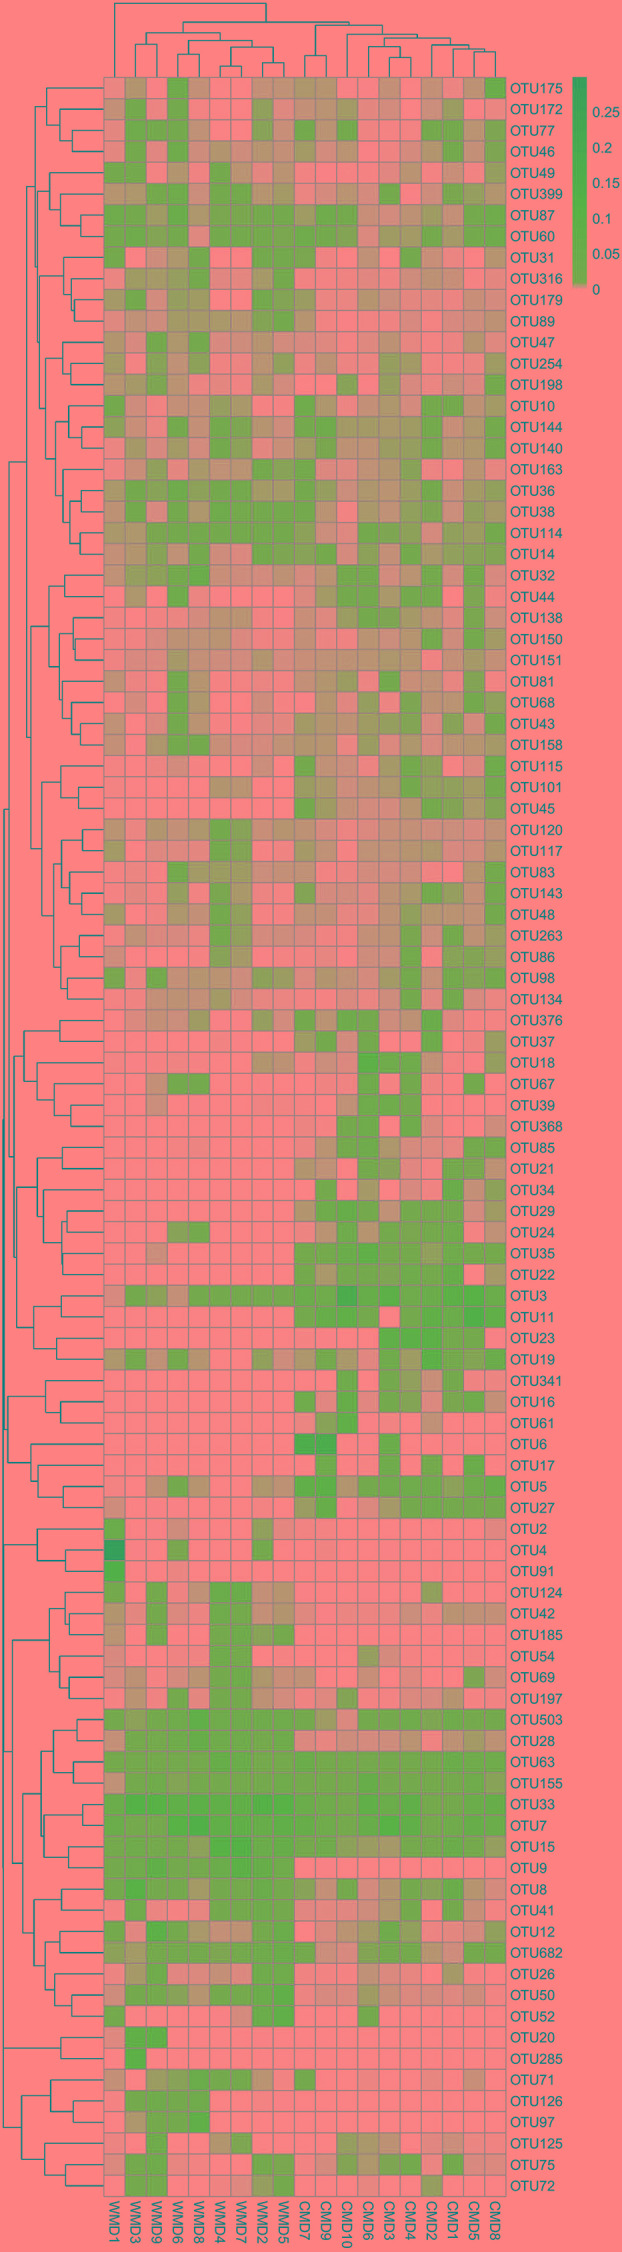
Heatmap of the 100 most abundant OTUs. Title for rows are OTU ID and title for columns are sample information. The left side of the graph is the OTU clustering tree and top is the sample cluster tree. Each color of the grid in the middle heatmap represents the value of the OTU relative abundance in each row after normalization processing.